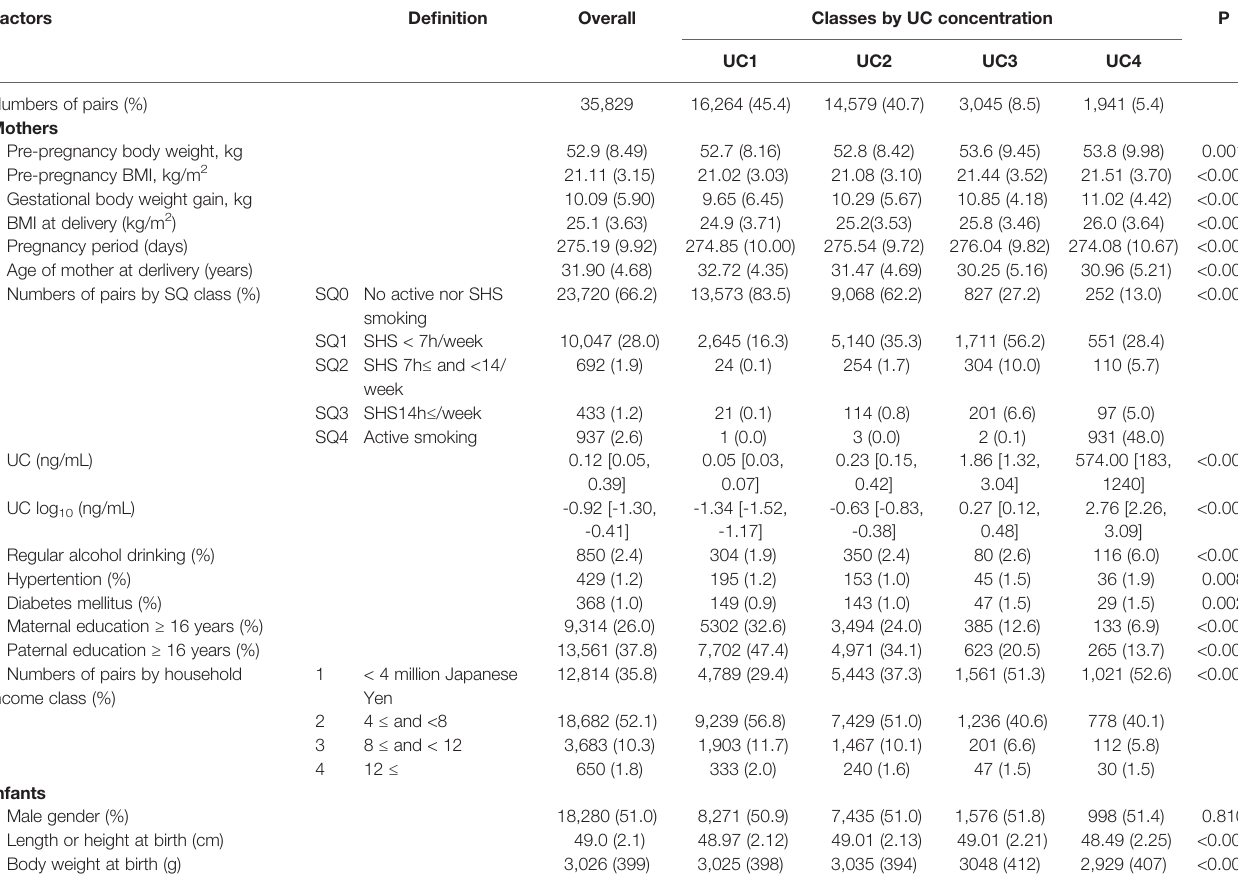
TABLE 1 | General characteristics of 35,829 list-wise participants in classes of urine cotinine (UC) concentration. Factors De fi